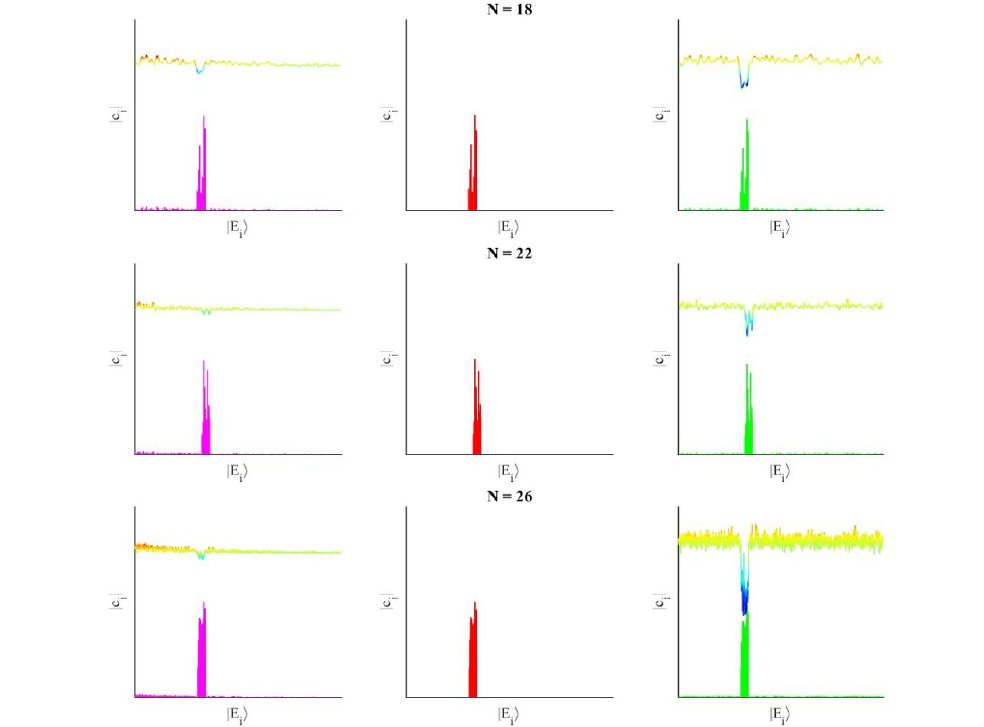
Figure 20 . Distribution of j c i j in non-equilibrium state of the form U ( e S i ) j (cid:9) 0 i (magenta), typical equilibrium state j (cid:9) 0 i (red), and non-equilibrium state of the form U ( S i ) j (cid:9) 0 i (green). The line above the bar plot shows, in heat map colors, which eigenstates are excited, and which ones are suppressed because of the perturbation. Blue eigenstates are suppressed, while eigenstates with other colors are excited with small (green), medium (orange), or large (red) magnitude.